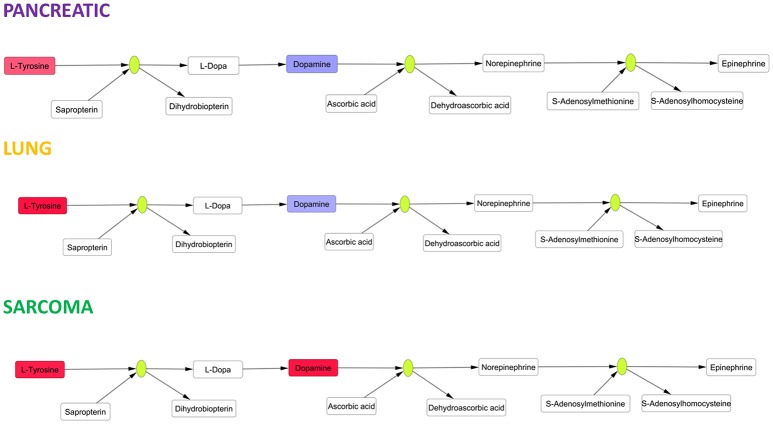
Schematic representation of SMPDB Catecholamine biosynthesis pathway. Two compounds belonging to this pathway were measured: L-Tyrosine and dopamine. L-Tyrosine was up-regulated in all three cancer-bearing groups, while dopamine was only up-regulated in sarcoma-bearing groups. Red denotes upregulation as compared to controls; blue denotes downregulation as compared to controls. Green nodes represent enzymes.